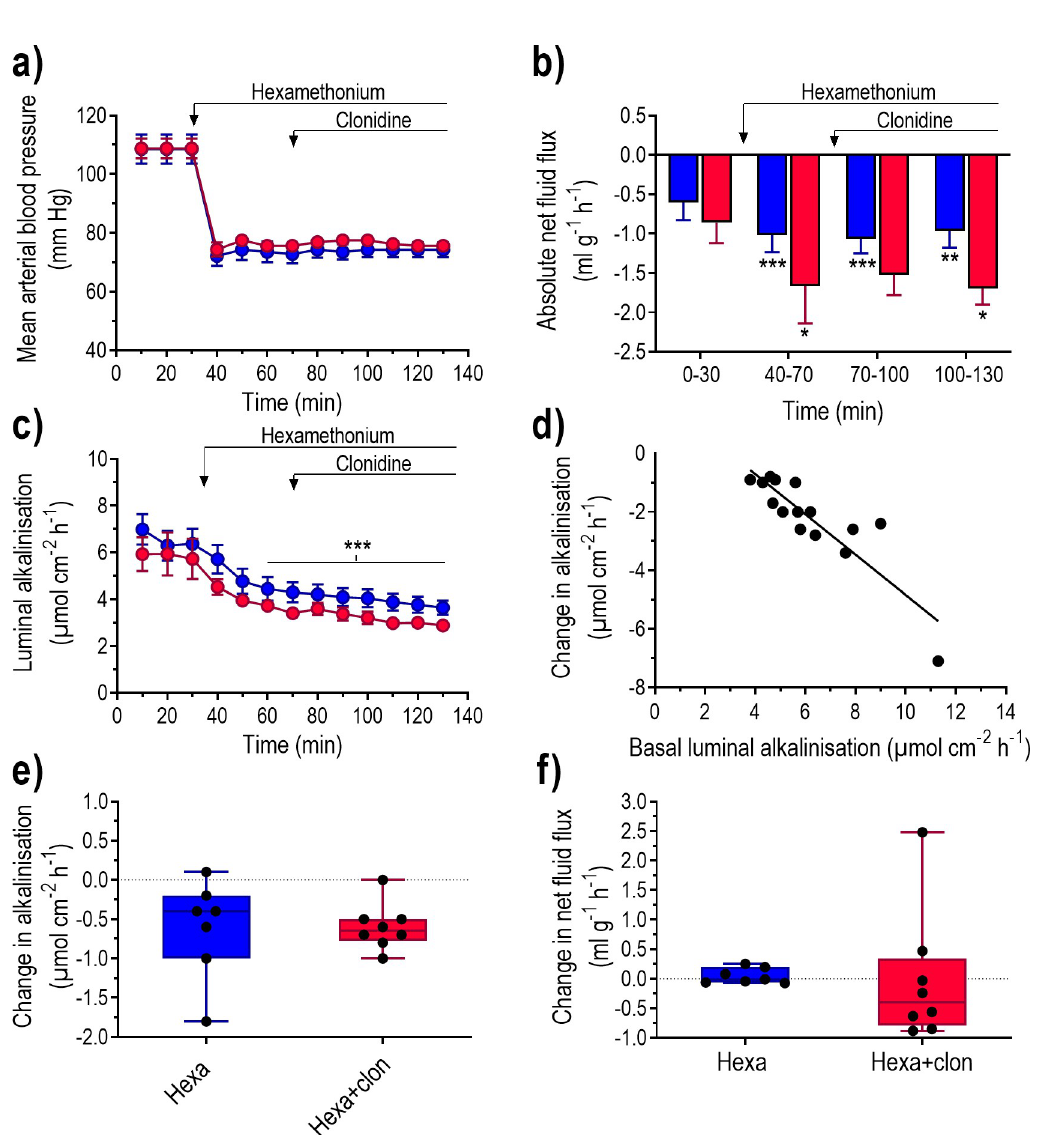
Fig 10. The effect of clonidine administered after treatment with a non-selective nicotinic receptor inhibitor (hexamethonium) on blood pressure, net fluid flux and luminal alkalinisation in the rat duodenum. Duodenum was perfused with isotonic saline for 130 min with hexamethonium (i.v. 10 mg kg -1 h -1 ) from 30 min followed by clonidine (i.v. 10 μ g kg -1 h -1 ) from 70 min (Fig 1). Effects on (a) mean arterial blood pressure, (b) transepithelial net fluid flux, and (c) luminal alkalinisation with. The (d) relationship between the basal luminal alkalinisation and the changes in luminal alkalinisation in response to hexamethonium compared to baseline (0–30 min). Changes in (e) luminal alkalinisation and (f) transepithelial net fluid flux between 100–130 and 40–70 min in animals treated with hexamethonium alone and hexamethonium plus clonidine. Values are means ± SEM or box plots with all individual points. �� P < 0.01 and ��� P < 0.001 compared with basal values. ψ P < 0.05 and ψψ P < 0.01 compared with values at time point